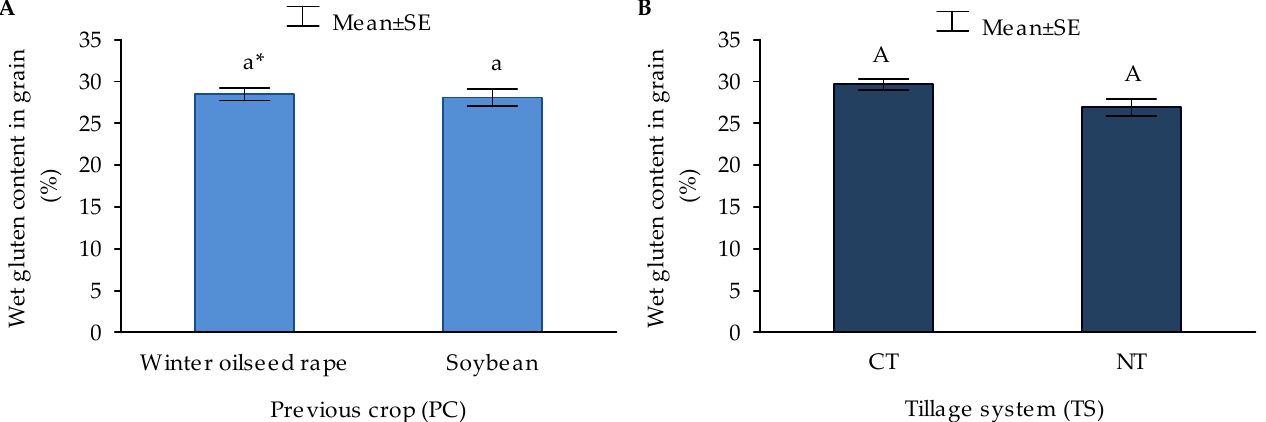
Figure 6. Wet gluten content in winter wheat grain depending on previous crop ( A ) and tillage system ( B ) (mean for 2014–